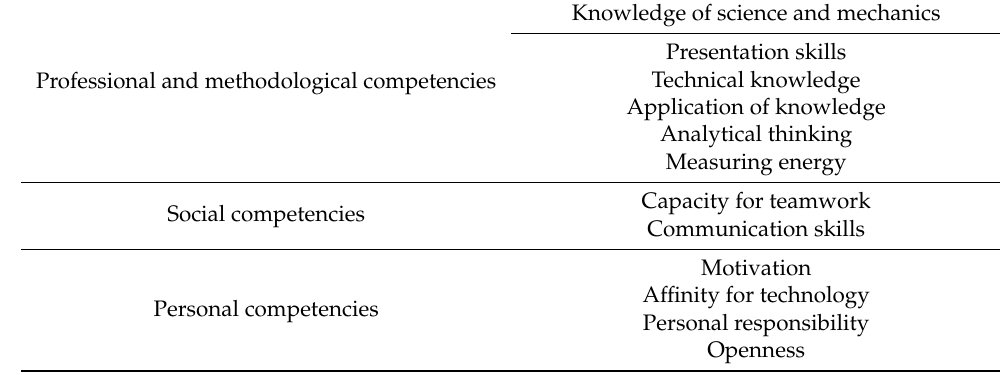
Table 4. Overview of